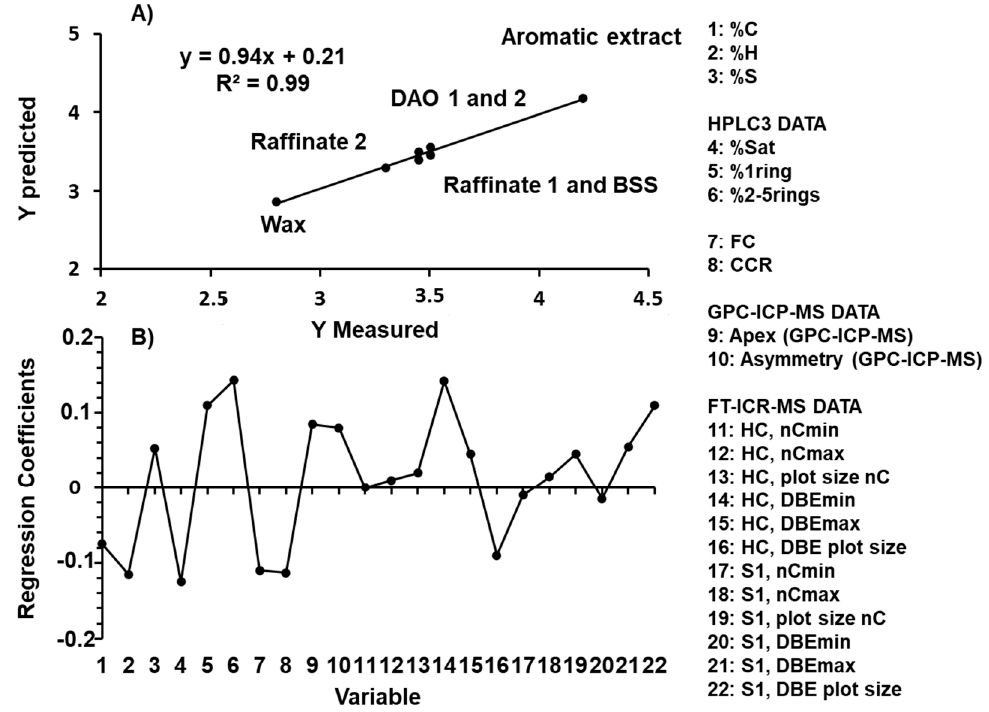
Figure 11. Calibration curves between the viscosity predicted by partial least square (PLS) and measured ( A ) except for the VR sample. Influence of 22 different variables on viscosity ( B ).